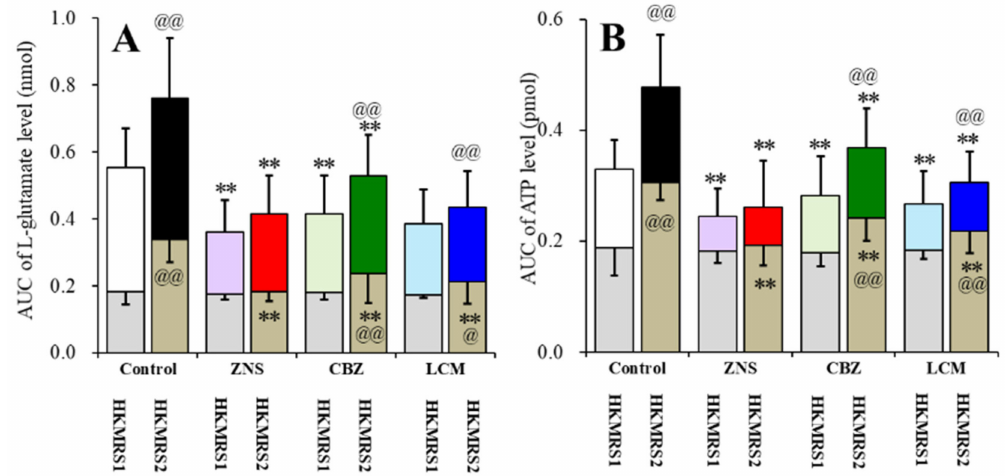
Figure 9. E ff ects of the subchronic administration of a therapeutic-relevant dose of ZNS, CBZ, and LCM (25 mg / kg / day for 7 days) on the repetitive FCHK-MRS-evoked (first stimulation: